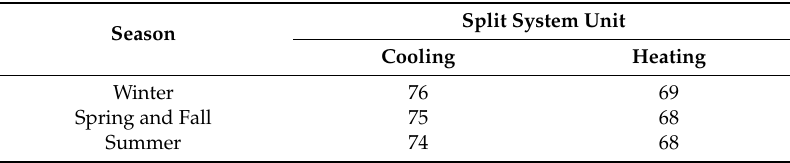
Table 8. Heating / cooling set-points in